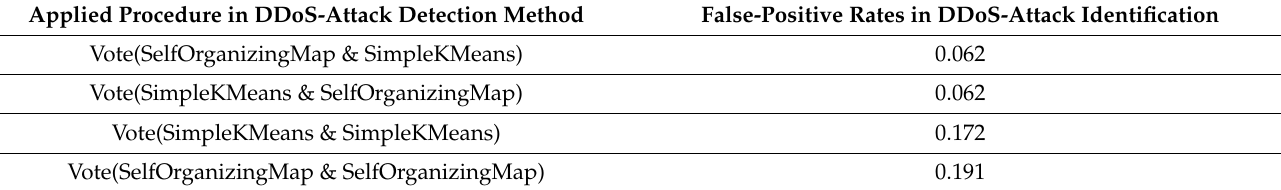
Table A3. False-positive rates using the filter